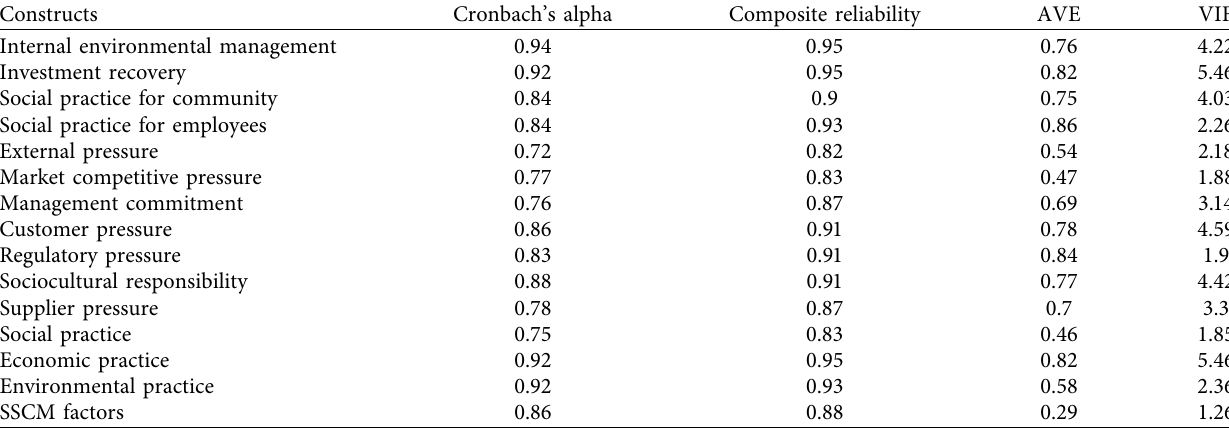
Table 10: Statistical quality indicators for the revised model.